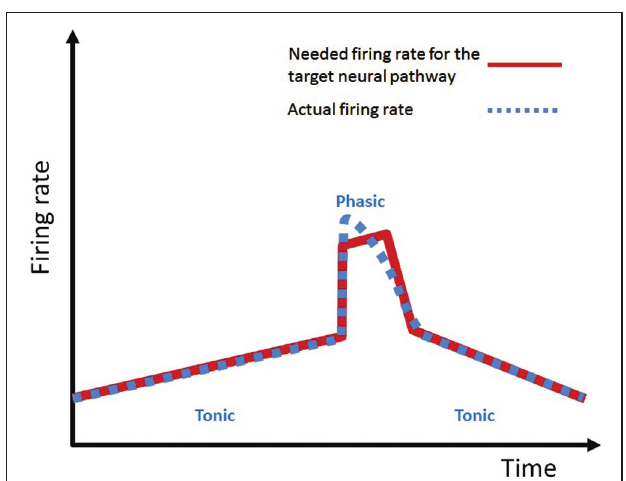
FIGURE 2 | “Demand-Supply” concept of DA firing activity . The tonic (slow temporal scale: good at slow variation of firing over time, bad at instantaneous jump or dip) and phasic (fast temporal scale: good at instantaneous jump or dip, bad at slow variation over time) components of DA firing modes are utilized to meet the requested DA firing rate pattern (in multiple time scales) for the target neural